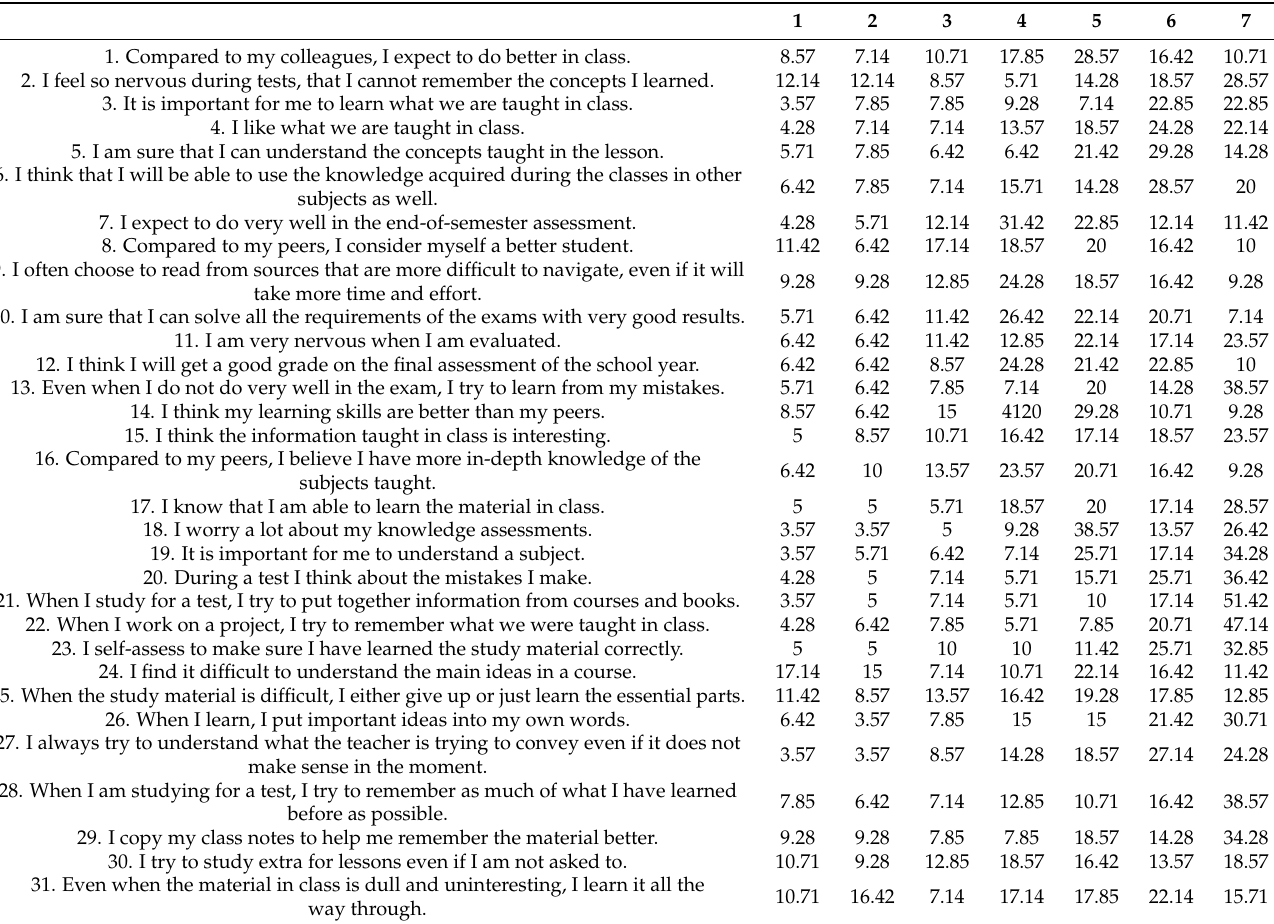
Table 2. Part II: Students’ behavior in the online classes